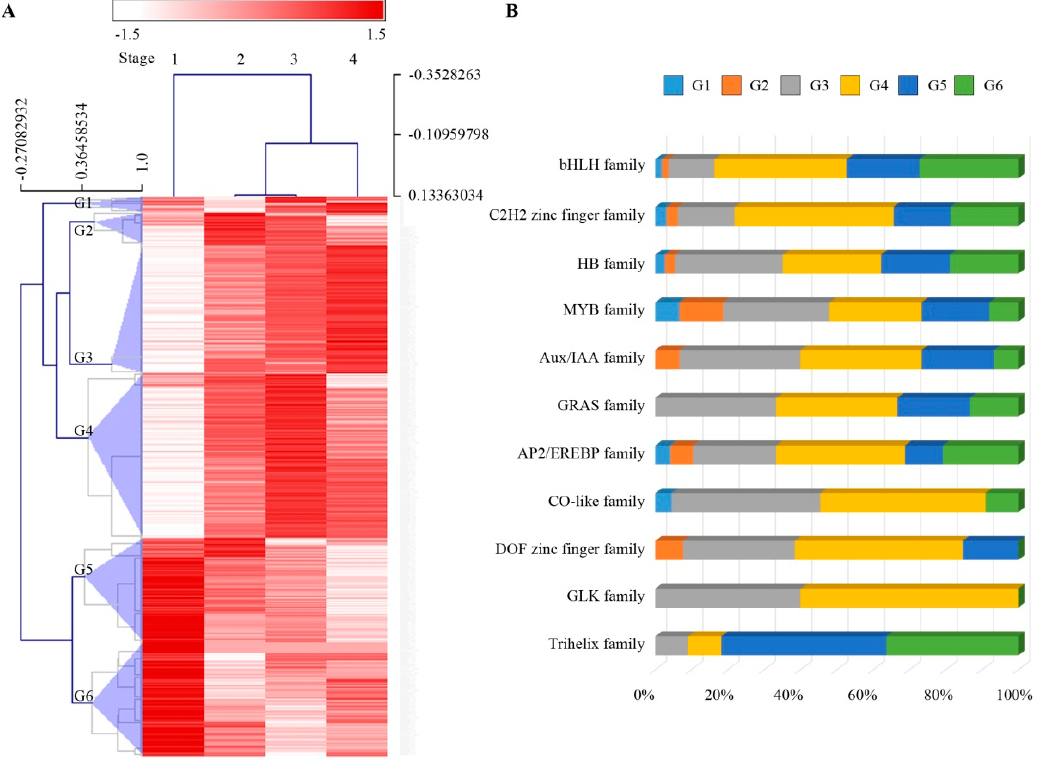
Figure 4. Dynamics of accumulated transcription factor profiles. ( A ) Hierarchical clustering (HCL) of the transcription factors related to sheath maturation in maize, six lineages (G1 to G6) were identified. The bar represents the expression of transcription factors normalized by row across four stages during sheath maturation in the HCL program. ( B ) Distribution of transcription factor families in groups G1 to G6 in the leaf sheath.